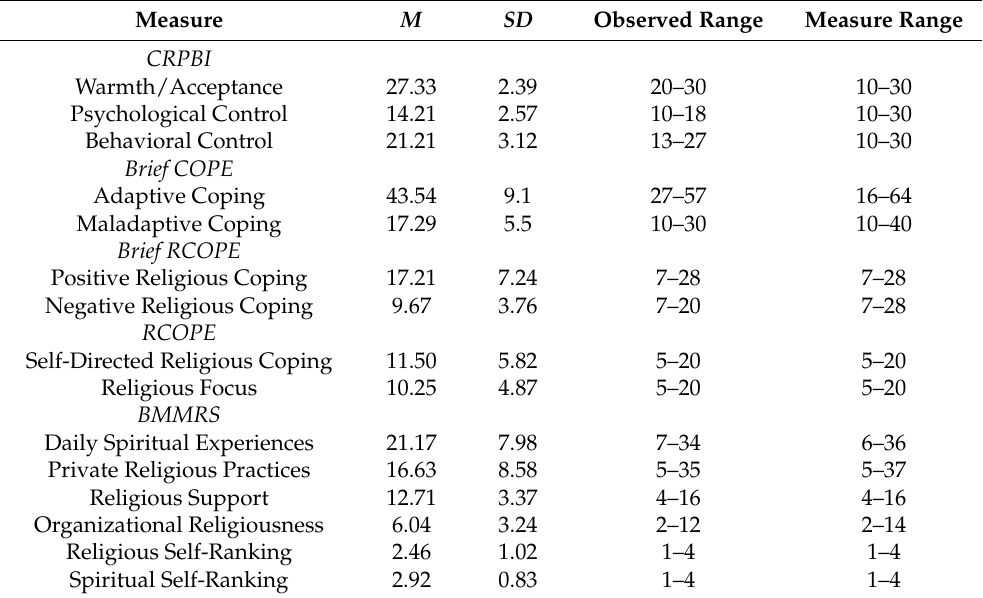
Table 1. Descriptive statistics for parenting dimensions, parents’ coping strategies, and parental religiosity.